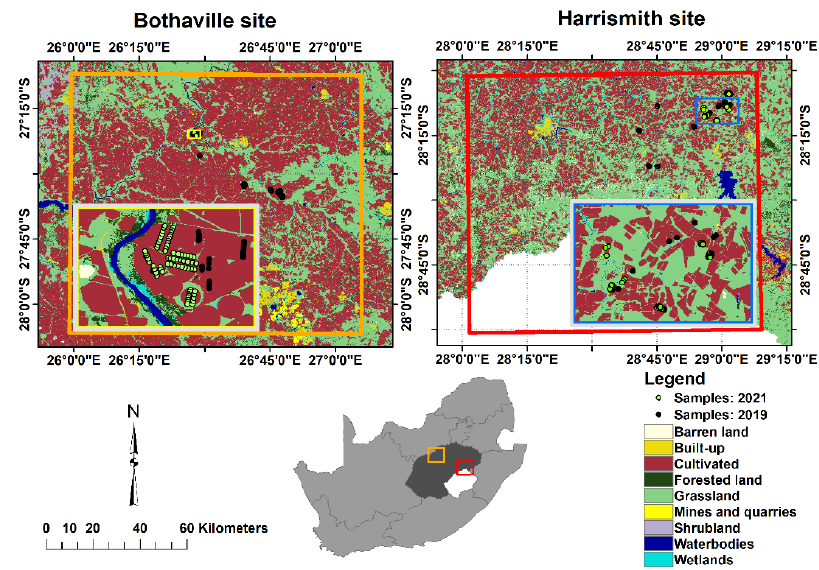
Figure 1. The location of Bothaville (i.e., Orange square) and Harrismith (i.e., Red square) in Free State province (Dark grey), South Africa, as well as the broad land cover types and the locations of the sampling plots. The insert maps for each site (in yellow and blue) are zoomed-in